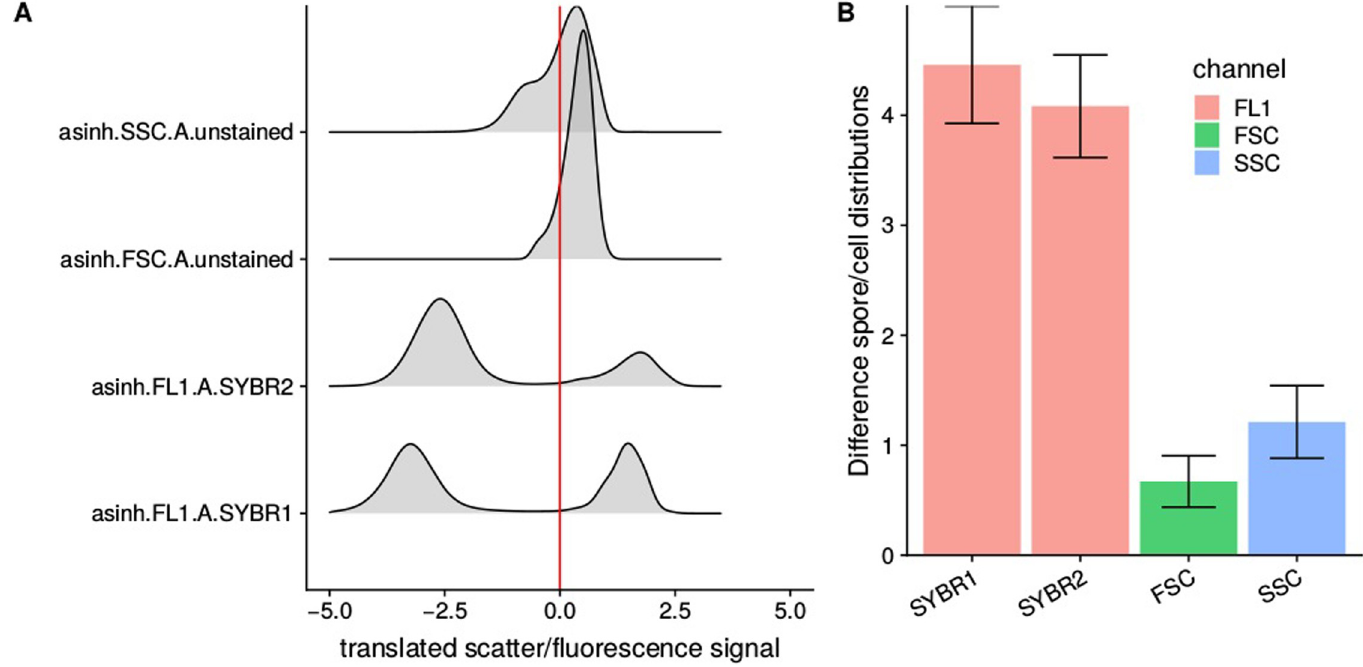
Fig 2. Comparison of different dyes and channels used for optimal separation of cells and spores (time = 30 minutes, concentration = 2 fold). (A) Raw data and cutoff values based on GMM. X-axis shows translated signal, so that the threshold is always at 0. (B) Distance between normal distributions as predicted by GMM in the respective channels with error bars showing the pooled standard deviation. The same metric was used to evaluate the effect of staining time, stain concentration (S1 Fig).